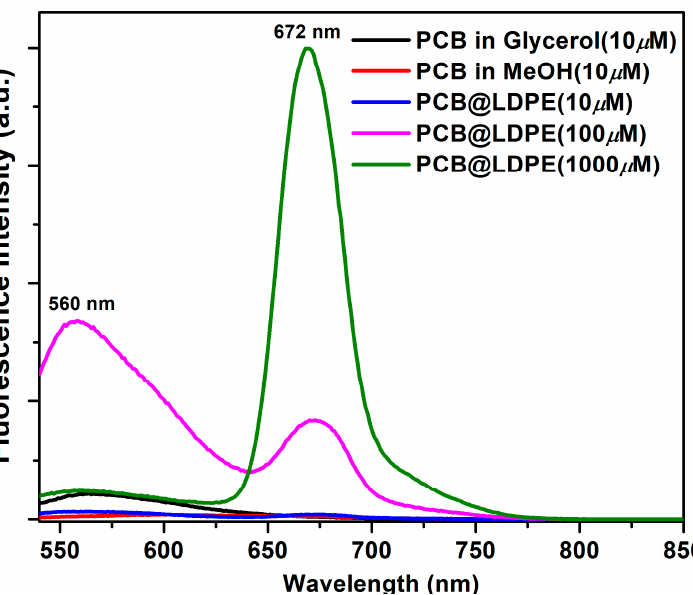
Figure 2. Evolution of the PL spectra of solid LDPE plastic film upon adding different concentrations of PCB dyes in methanol under vacuum at 298 K (solid samples were excited at 510 nm). The PL spectrum of PCB in glycerol was added for comparison.